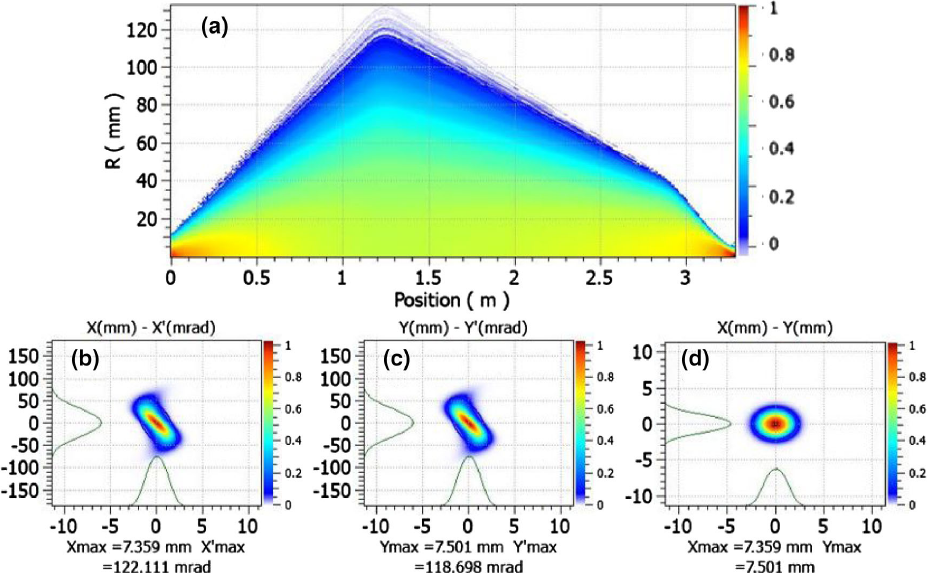
FIG. 6. (a) Particle density distribution in the x-z plane along the MEHIPA LEBT, (b,c) phase space and (d) coordinate space particle density distribution in the transverse plane.